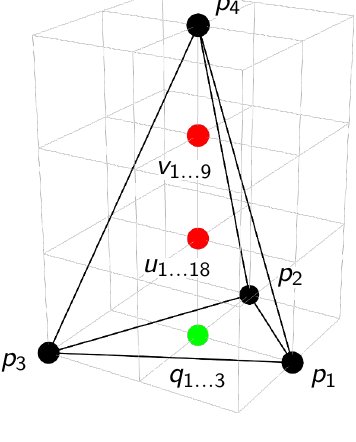
Figure 13 . Toric diagram of Y 3 , 0 ( CP 2 ) .